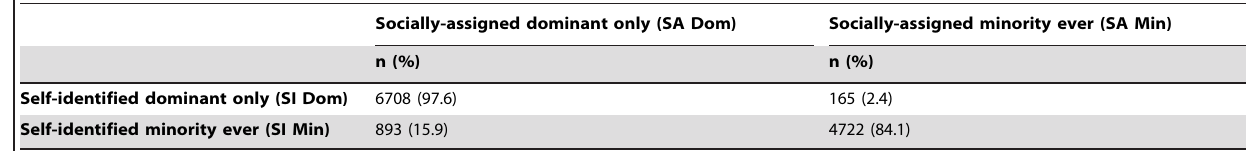
Socially-assigned dominant only (SA